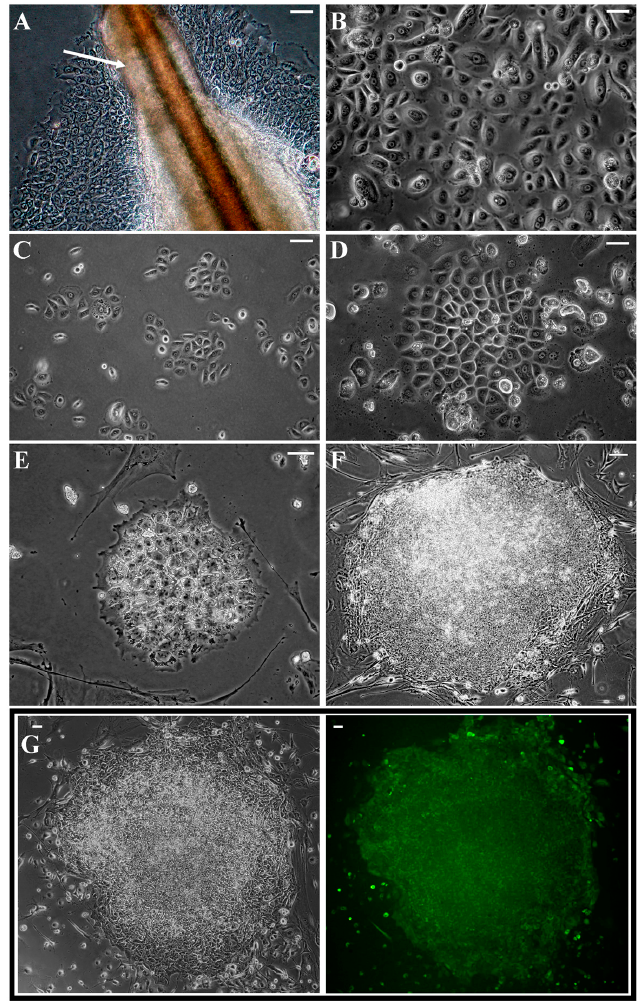
Figure 1. Isolation and reprogramming of plucked-hair keratinocytes: ( A ) keratinocytes migrating from plucked-hair outer root sheath (ORS), ORS is marked with white arrow; ( B ) morphology of isolated keratinocytes after their subculture and expansion; ( C ) isolated keratinocytes one day before infection; ( D ) morphology of transduced keratinocytes changed to epithelial within four days after